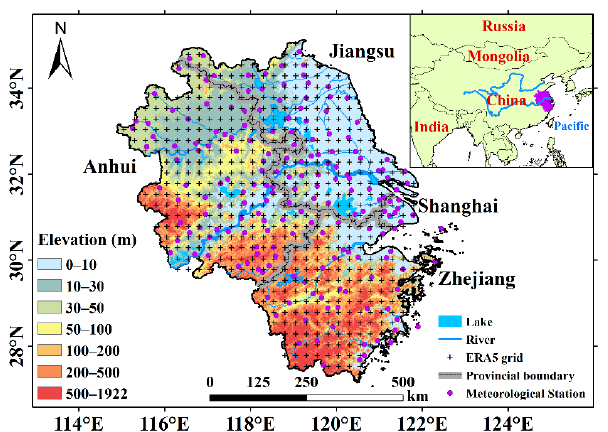
Figure 1. Locations of 185 meteorological stations and 549 ERA5 grid points in the YRD.